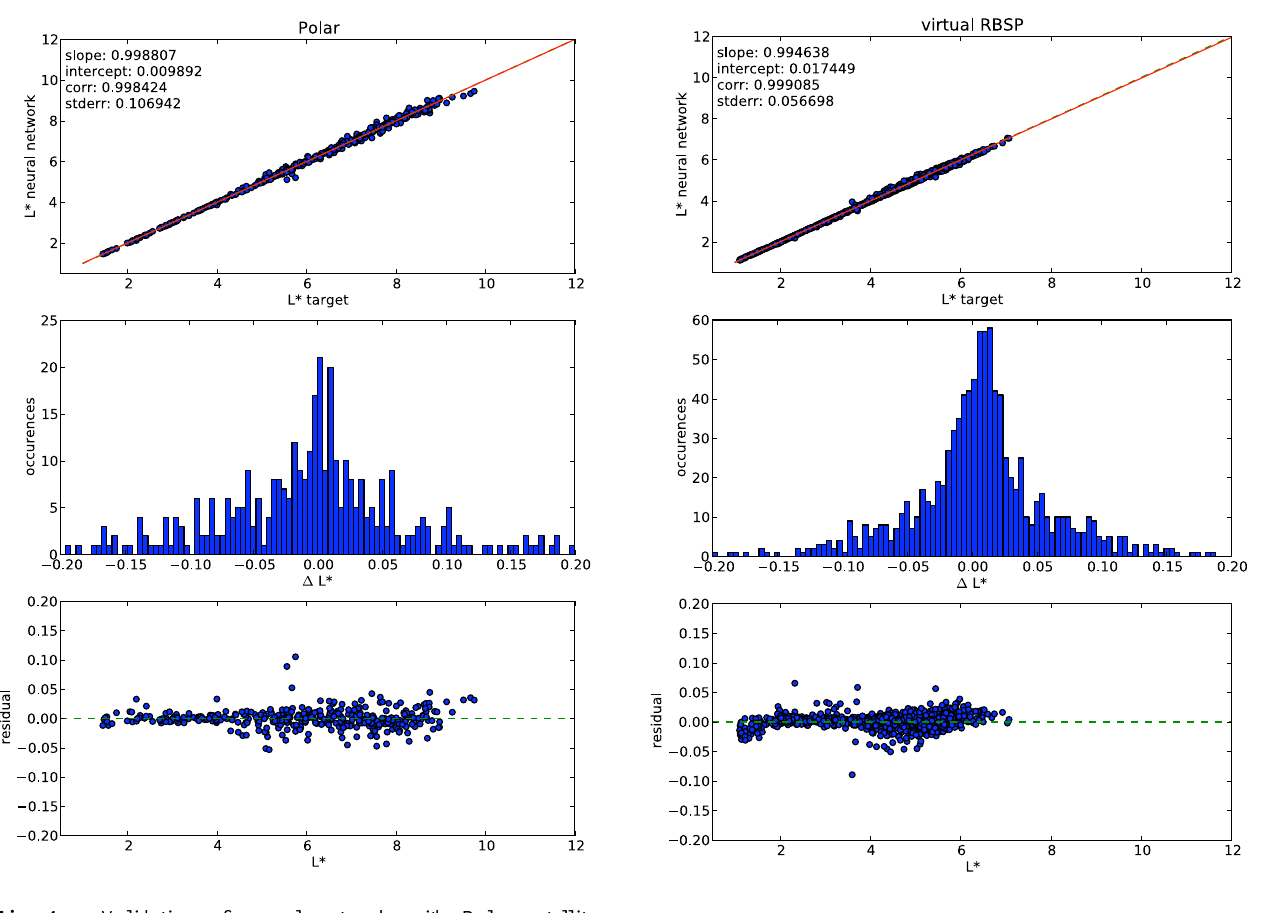
Fig. 5. Validation of neural network with ephemerides from one of the RBSP satellites using an example ephemeris file of this fu- ture mission and mapping them to solar wind condition between February 2000 and January 2002. Top: scatter plot of L ∗ values from TS05 model (target) against neural network results. Green- dashed line indicates a perfect fit and red solid line indicates the least-square fit to the scatter plot. One thousand ephemeris points and solar wind conditions were randomly chosen for the above time period. Middle: histogram plot of overall residuals from scatter plot. Bottom: residual plot as a function of L ∗